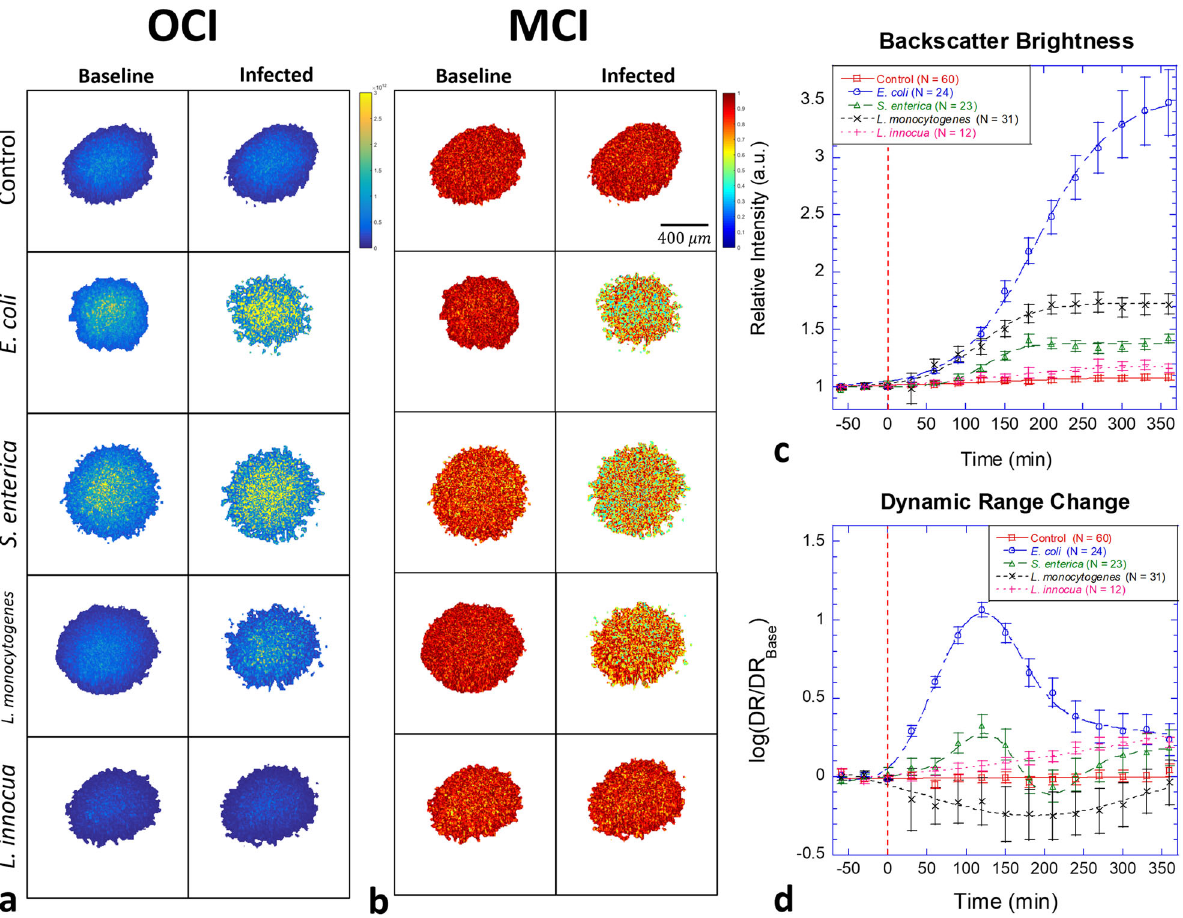
Fig. 2 Examples of DLD-1 multicellular tumor spheroids before and after infection. a Optical coherence images (OCI) of the optical mid-sections from DLD-1 spheroids showing backscatter brightness before (left) and 6 h after (right) infection by 10 7 bacterial CFU per well. The strongest increase in backscatter brightness (BB) occurs for E. coli (note second OCI column). b Motility contrast images (MCI) for the same samples. The growth of the bacteria causes a strong inhibition of Doppler activity for E. coli (note second MCI column) and moderate inhibition of Doppler activity for Listeria monocytogenes and Salmonella enterica serovar Enteritidis. Slowly proliferating Listeria innocua shows the smallest effect. The scale bar applies to all speckle images. c Temporal evolution in BB as a function of time after inoculation (red dashed line). Infection by E. coli produces a large increase in BB. d Dynamic range (DR) of the spectral density changes non-monotonically as a function of time. The error bars represent standard